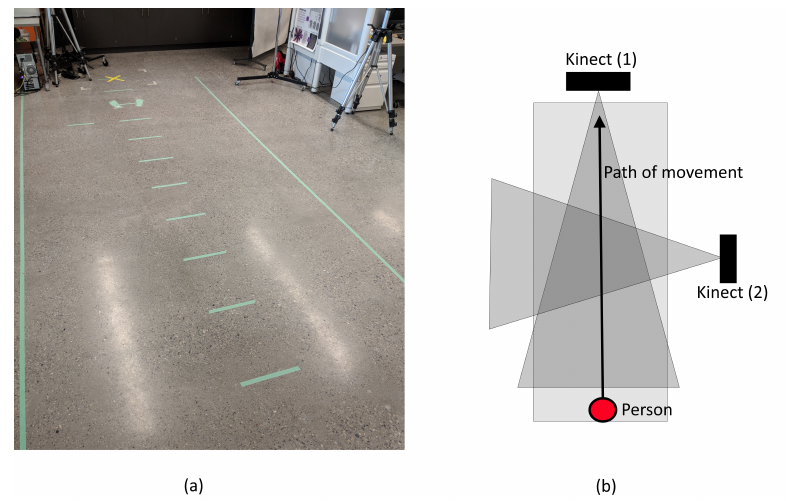
Figure 4. Diagram of setup used for gait data collection: ( a ) the actual setup; and ( b ) a view from above.